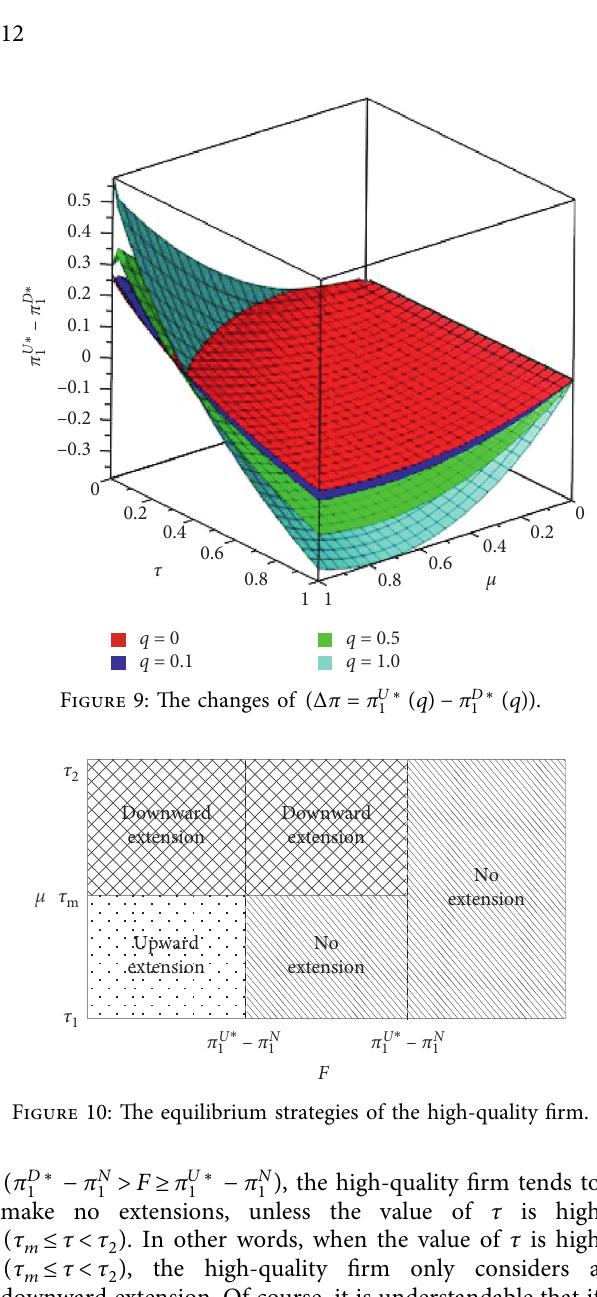
Figure 10: The equilibrium strategies of the high-quality